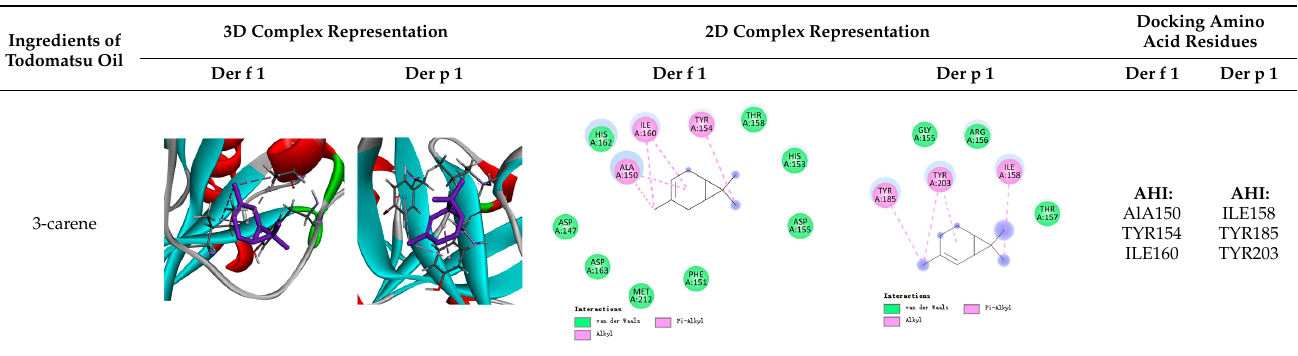
Table A1. 2D and 3D diagrams of ingredients-of-todomatsu oil (except top 5 ingredients) on aller-